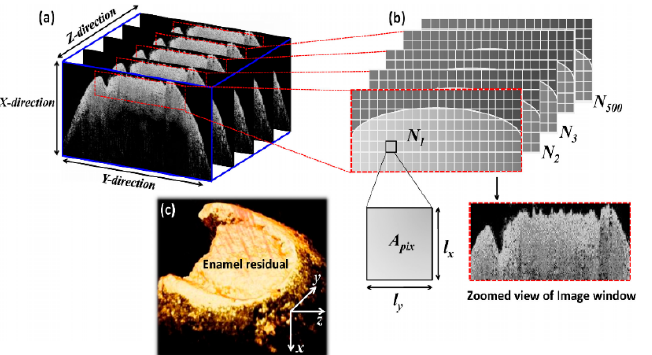
Figure 5. Evaluation algorithm for the volume of residual enamel. ( a ) 2D images with the applied image window; ( b ) Pixels that meet the predetermined intensity cut-off points; ( c ) 3D volumetric image. This figure was adapted from